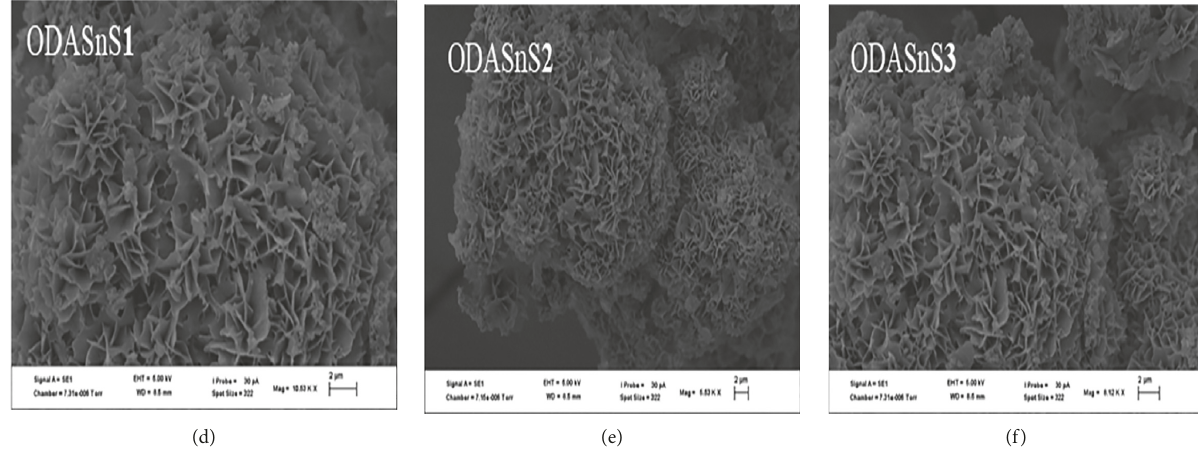
Figure 3: SEM images of OASnS1 (a), OASnS2 (b), and OASnS3 (c). SEM images of ODASnS1 (d), ODASnS2 (e), and ODASnS3 (f).